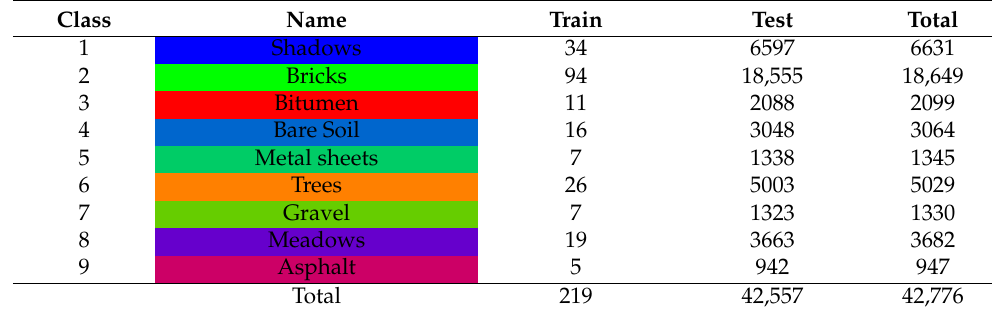
Table 2. Train-test distribution of samples for the Pavia University dataset.